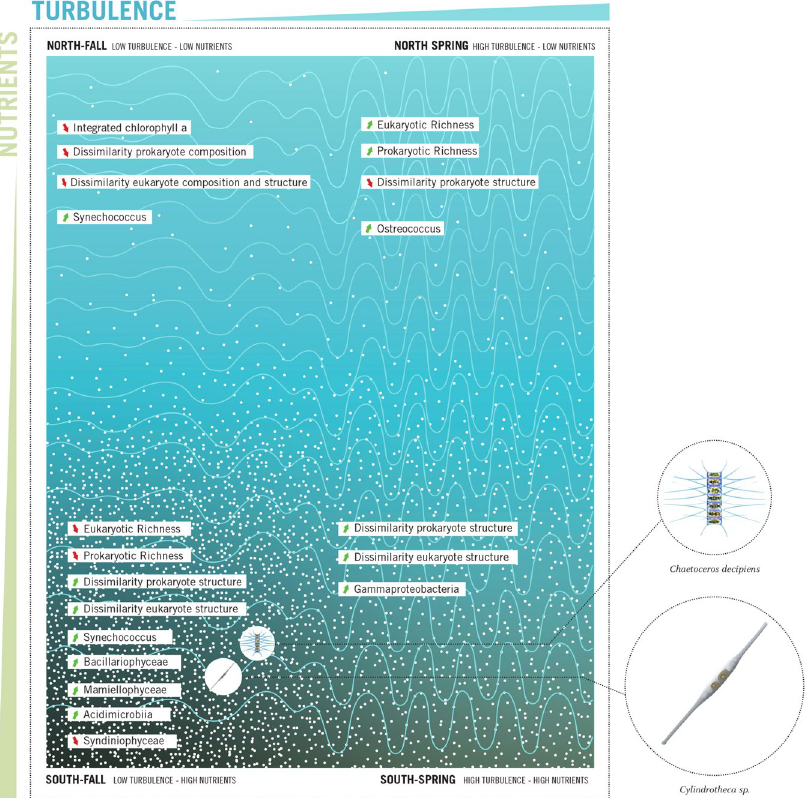
Figure 6. Generalized depiction of the responses of the microbial community in the Red Sea to variations in nutrients and